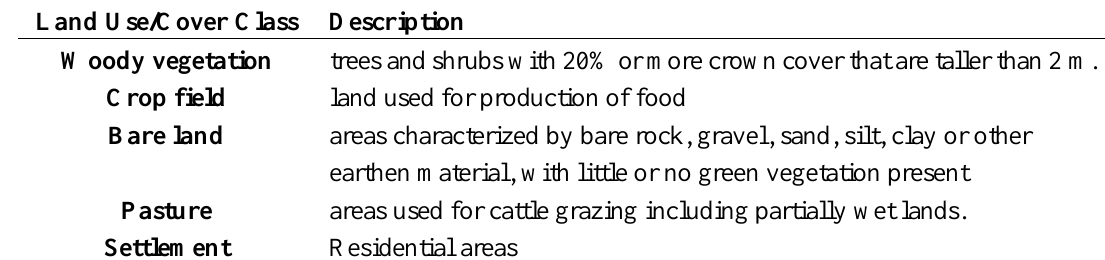
Table 1. Definition of the land use/cover classes in the Koga